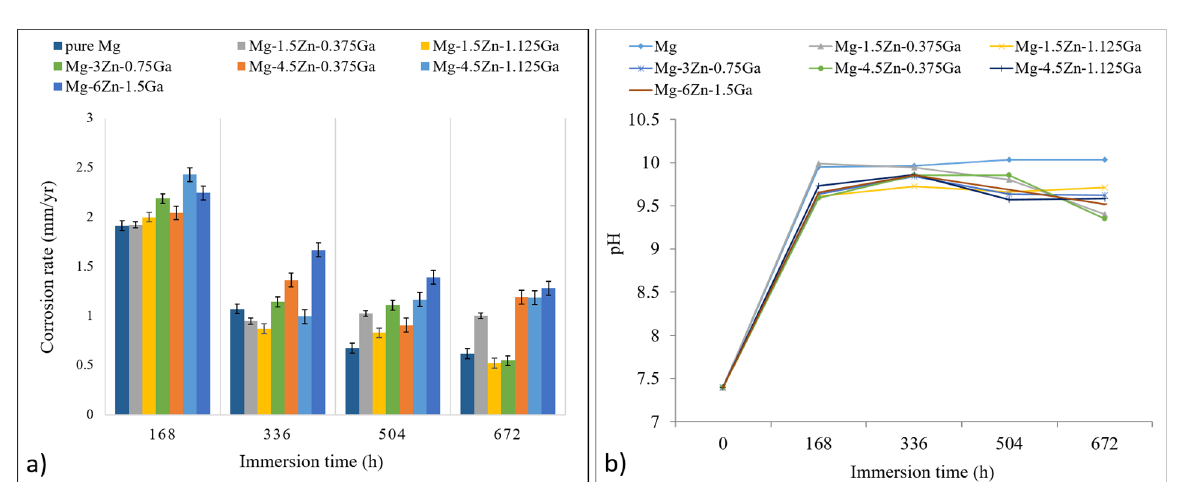
Figure 8. ( a ) Corrosion rate of the ternary as-cast Mg-Ga-Zn alloys and ( b ) variation in pH of SBF at the di ff erent immersion periods.